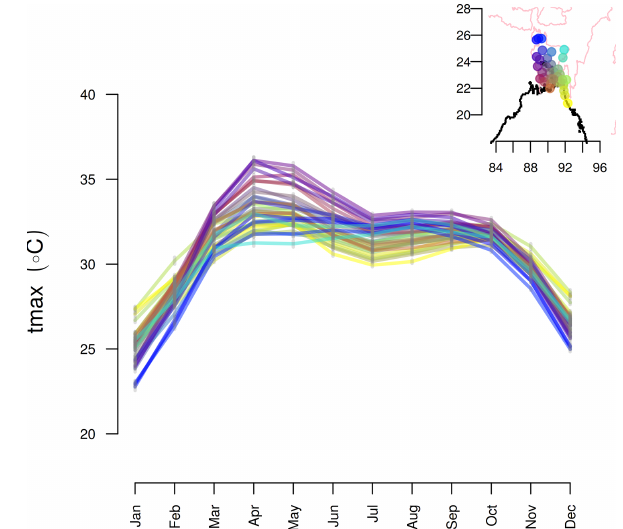
Figure 2. The mean seasonal cycle of the daily maximum temper- ature in Bangladesh, based on observations from 1981–2019. The colors represent the geographical location of the stations as shown in the map in the upper right corner.